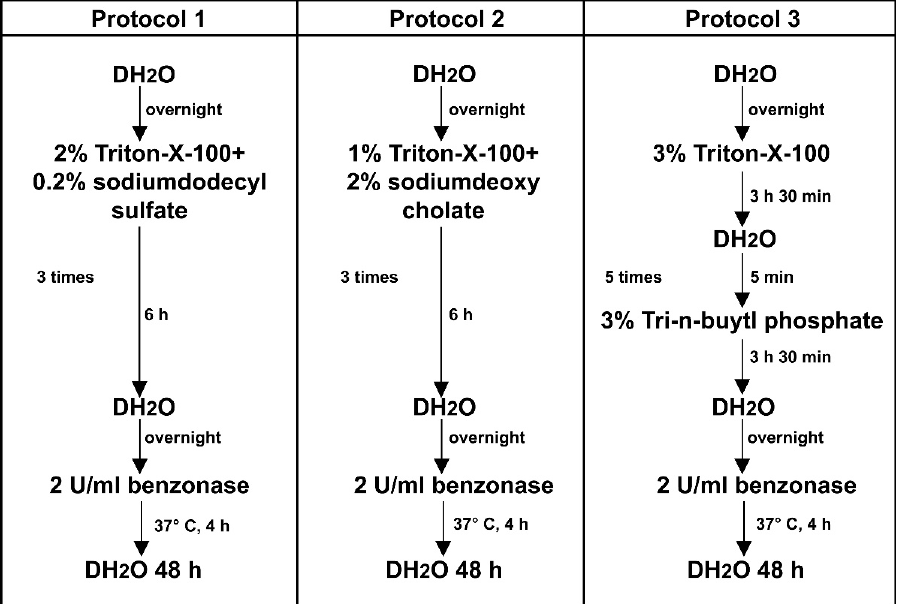
Figure 1. Decellularization protocols. Schematic diagram showing different steps of the nerve tissue processing, using protocols P1, P2, and P3. Immunostaining of the decellularized nerves for neurofilaments in axons (NF 200, Figure 2A–D) demonstrated complete absence of NF 200-positive profiles after using all three tested protocols. Staining for myelin-associated glycoprotein (MAG, Figure 2E–H) was largely preserved after application of the P1 and P2 protocols. However, following treatment with the P3 protocol, we consistently found small areas in the nerves devoid of MAG-labelling. Counterstaining of the nerve tissue sections with DAPI showed the ab- sence of nuclei after treatment with all three protocols (Figure 2B–D and 2F–H). DNA larized nerves when compared with normal untreated nerve tissue (Figure 2I,J). The re- maining genomic DNA was around 100 bp in length.